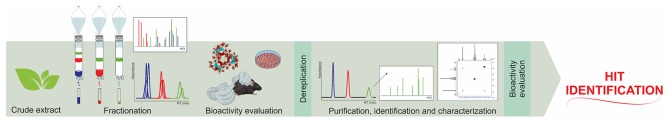
Classic bio-guided assay work chart for hit identification in a combinatorial natural product library.